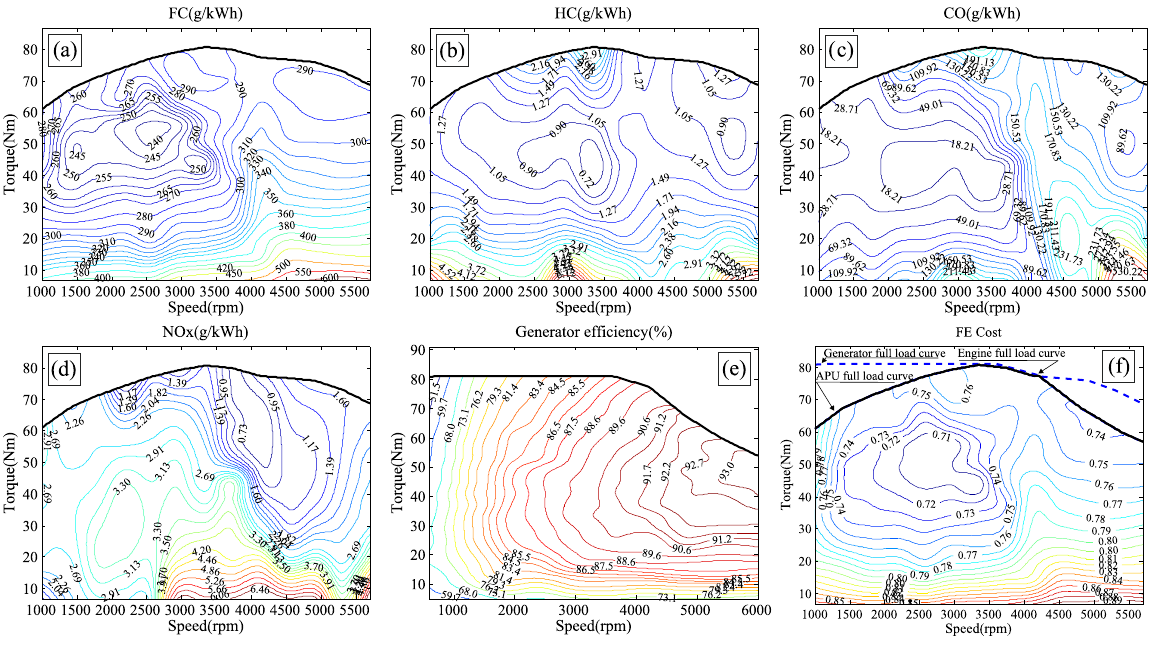
Figure 3. Speed-torque characteristics of the APU. ( a ) Fuel consumption (FC); ( b ) hydrocarbon (HC) emissions; ( c ) CO emissions; ( d ) NO x emissions; ( e ) generator efficiency; and ( f ) fuel-electricity conversion (FE)